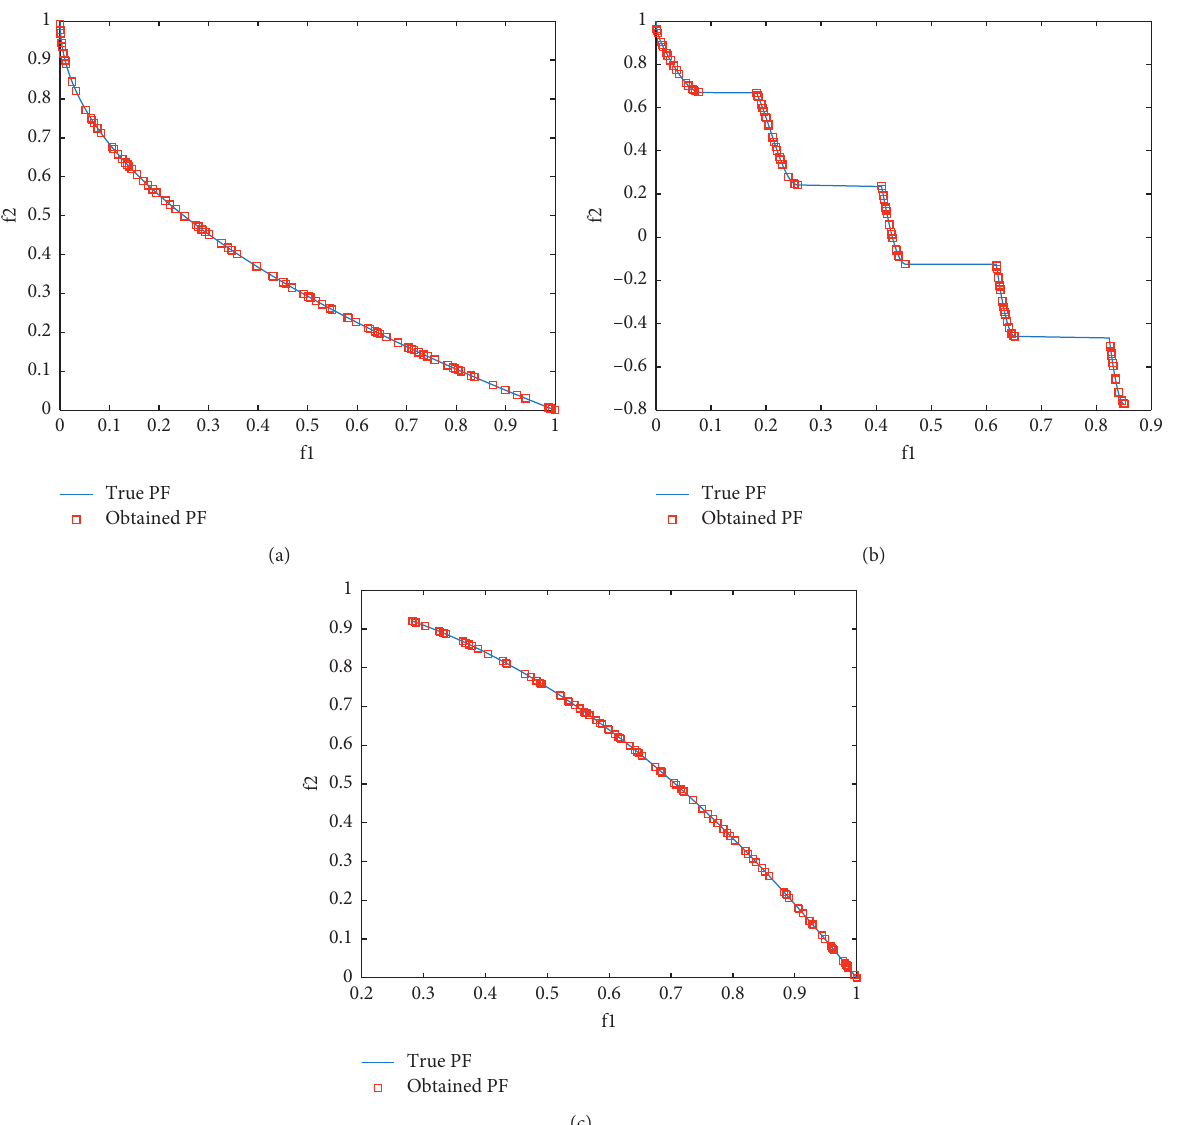
Figure 6: Pareto-optimal solutions obtained by HMOHHO for ZDT1, ZDT3, and ZDT6. (a) HMOHHO for ZDT1 problem, (b) HMOHHO for ZDT3 problem, and (c) HMOHHO for ZDT6